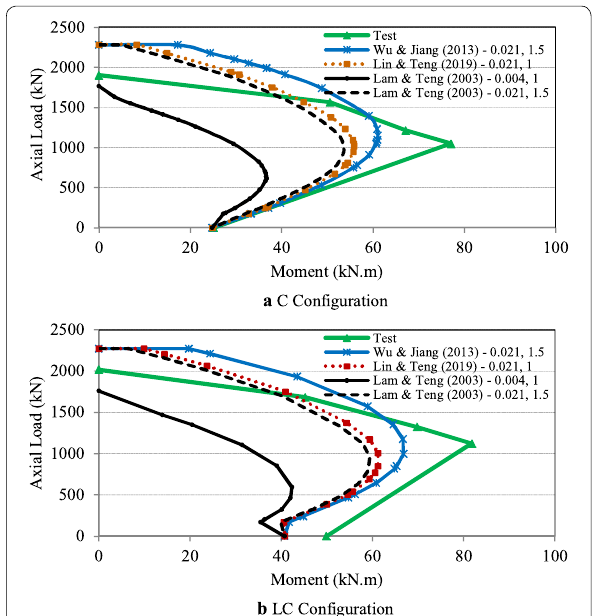
Fig. 13 Interaction diagrams for FRP‑ jacketed columns obtained using different stress–strain